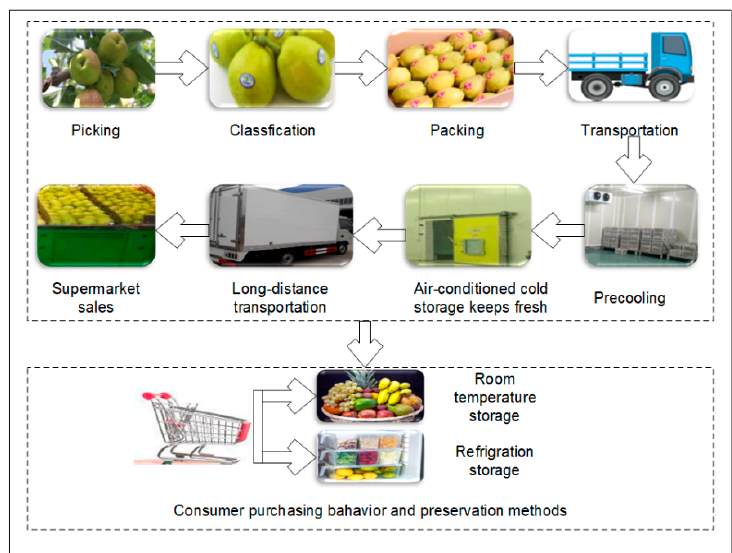
Figure 1. 'Korla' fragrant pear business flow. Figure 1. ‘Korla’ fragrant pear business